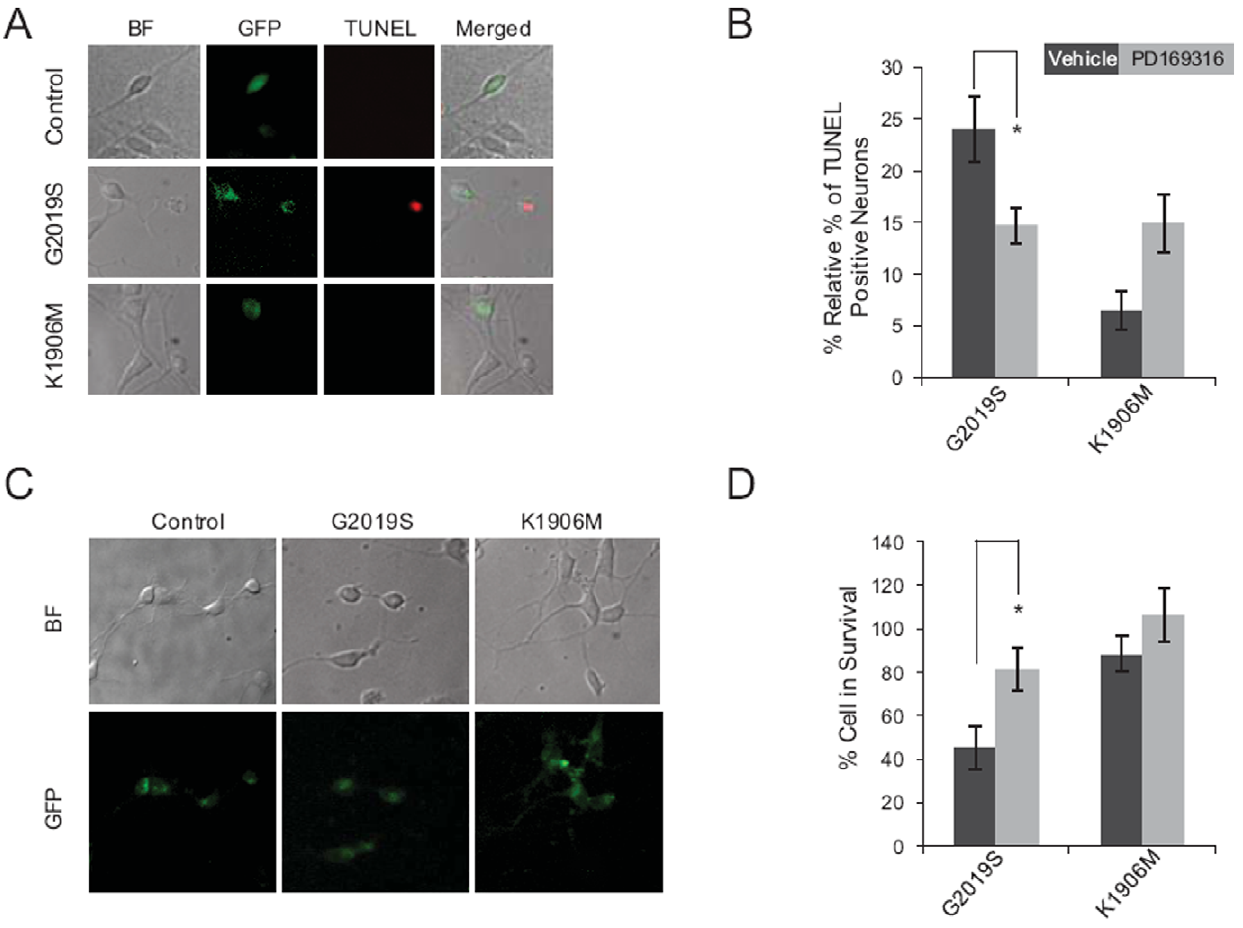
Figure 7. Activation of p38 contributes to cytotoxicity induced by G2019S mutant LRRK2 expression in murine neurons. Murine primary cortical neurons transfected with empty vector (control), K1906M or G2919S LRRK2 along with pEGFP vector were left untreated (vehicle) or incubated with 20 m M PD169316 for two days followed by TUNEL assay (a–b) or viability assay (C–D). ( A, C ) Representative fluorescent microscopic images of TUNEL assay (A) or viability assay (C). BF, bright field images; merged, merged images of BF, GFP and TUNEL. ( B, D ) Quantification of neuron apoptosis by TUNEL assay (B) or of neuron viability (D) demonstrates that p38 inhibition decreases the cytotoxicity of G2019S LRRK2 expressed in murine primary cortical neurons. For quantification of apoptotic cells, GFP- and TUNEL-positive neurons were counted as a percentage of total GFP-positive neurons in 40 6 microscopic fields. Percentages of TUNEL- positive control vector transfected neurons with or without PD169316 treatment were subtracted from the respective percentages of neurons transfected with other constructs. In viability assays, GFP-positive neurons with neurites (See Experimental Procedures) were counted as a percentage of total GFP-positive neurons. Data were normalized to neurons transfected with control vector. Data represent the mean 6 SEM of three independent experiments. * p , 0.05 by